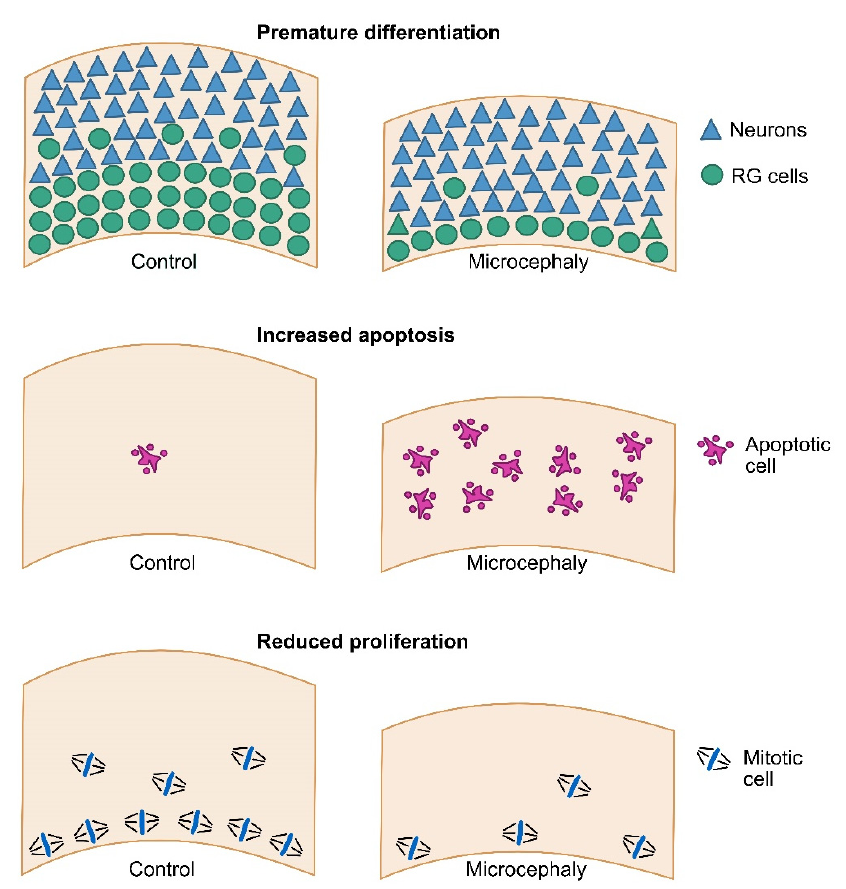
Figure 1. Major cellular causes of primary microcephaly. Three major causes of primary microcephaly have been reported, leading to a reduced total number of cells at birth. Premature differentiation refers to an excessive early generation of neurons, leading to an exhaustion of the progenitor pool.